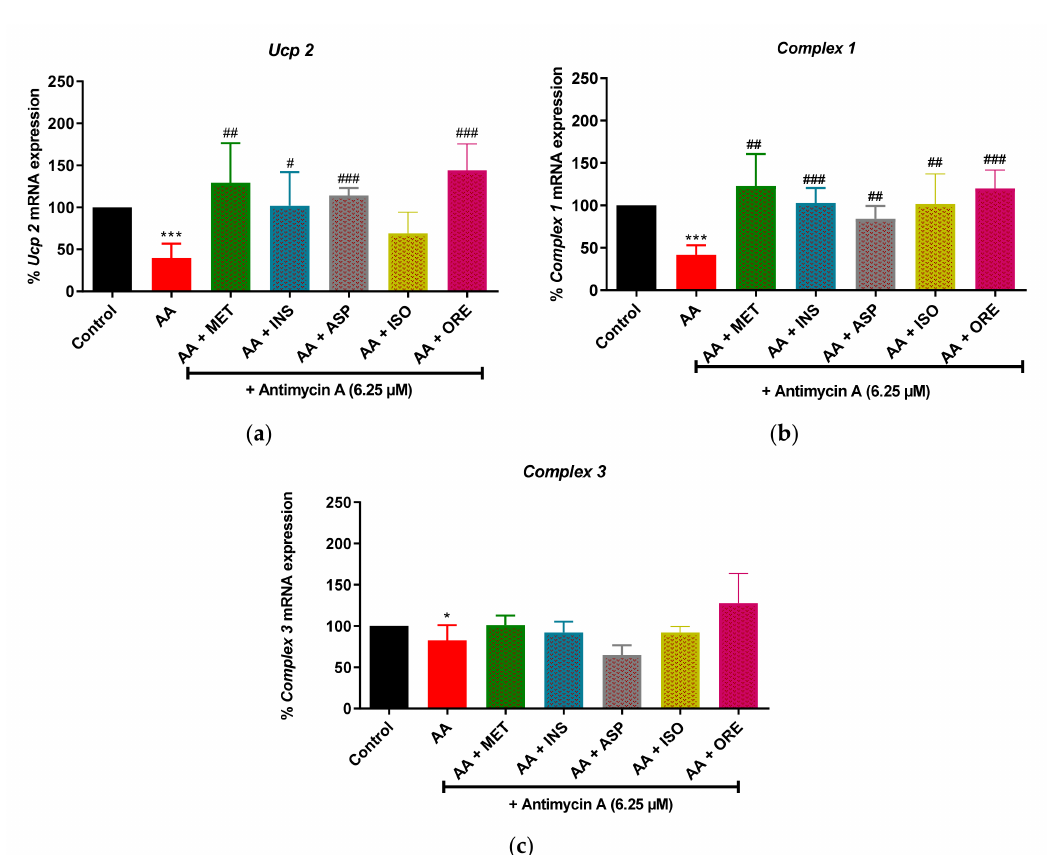
Figure 4. The effect of aspalathin, isoorientin, and orientin on the expression of mitochondrial bioenergetics genes; uncoupling protein 2 ( Ucp 2 ) ( a ), Complex 1 ( b ), and Complex 3 ( c ) in C2C12 cells exposed to antimycin A. Cells were exposed to 6.25 µ M antimycin A for 12 h, followed by treatment with aspalathin, isoorientin, orientin (10 µ M) and comparative control metformin (1 µ M) for 4 h. Insulin (1 µ M) for 30 min. Results are expressed as mean ± SD of three independent experiments. * p < 0.05, *** p < 0.001 versus normal control; # p < 0.05, ## p < 0.01, ### p < 0.001 versus antimycin A